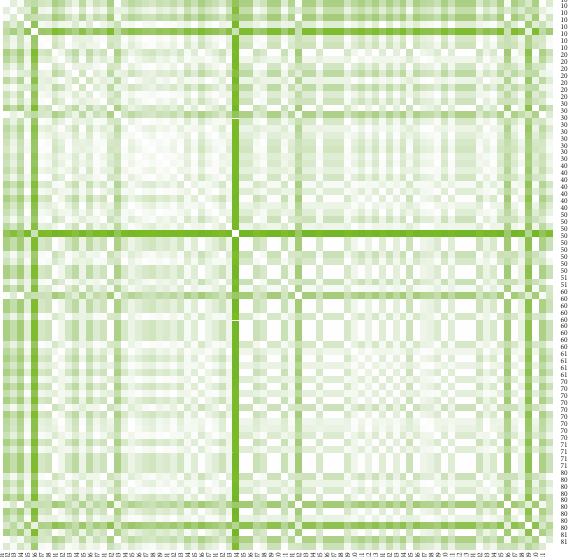
Figure 13: The distance matrix of the similarity of the districts for the female sex in 2005.